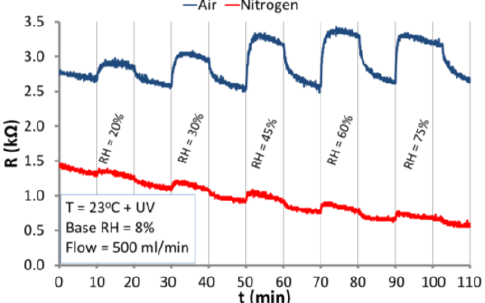
Figure 15. Responses of the ZnO nanostructures to RH changes under UV irradiation under atmospheres of air and nitrogen at RT (23 °C).